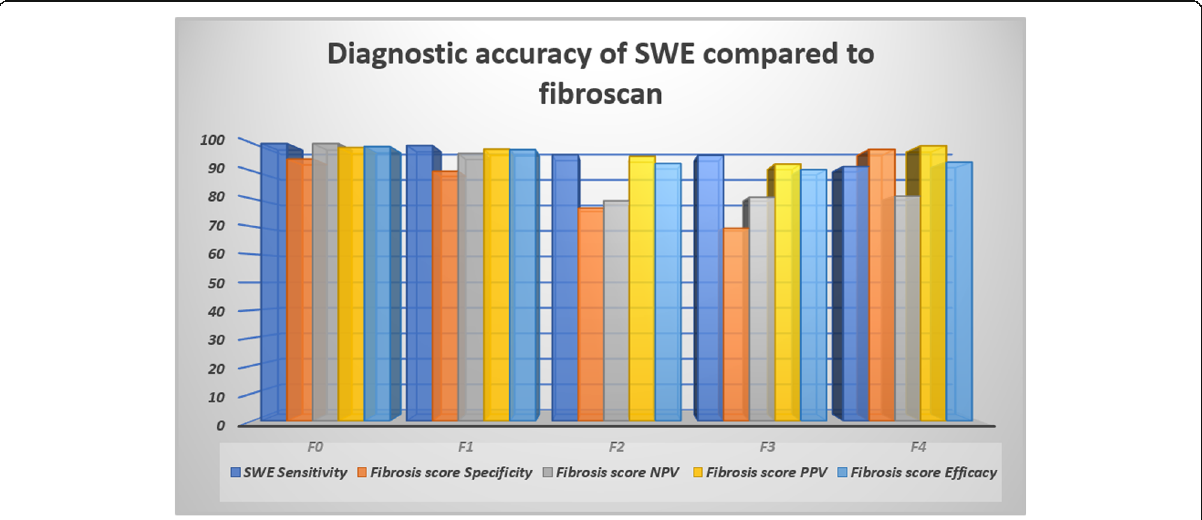
Fig. 3 The diagnostic accuracy of SWE compared to the TE fibroscan when using the TE fibroscan results as a reference